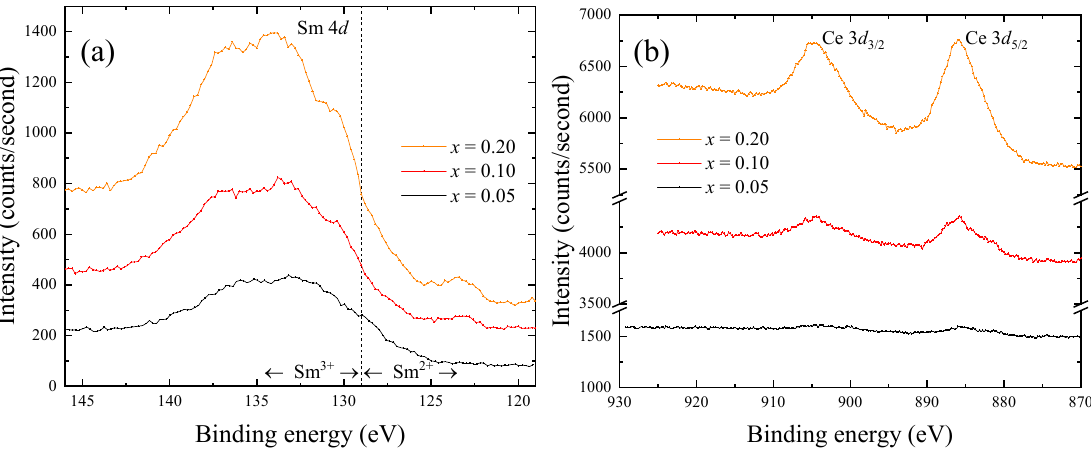
Figure 3. ( a ) Sm 4 d XPS spectrum and ( b ) Ce 3 d 3/2,5/2 XPS spectra collected for the Sm 1 − x Ce x B 6 ( x = 0.05, 0.10, and 0.20) crystal